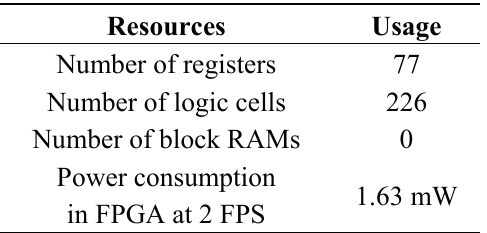
Table 8. FPGA Synthesis results of the compressor.